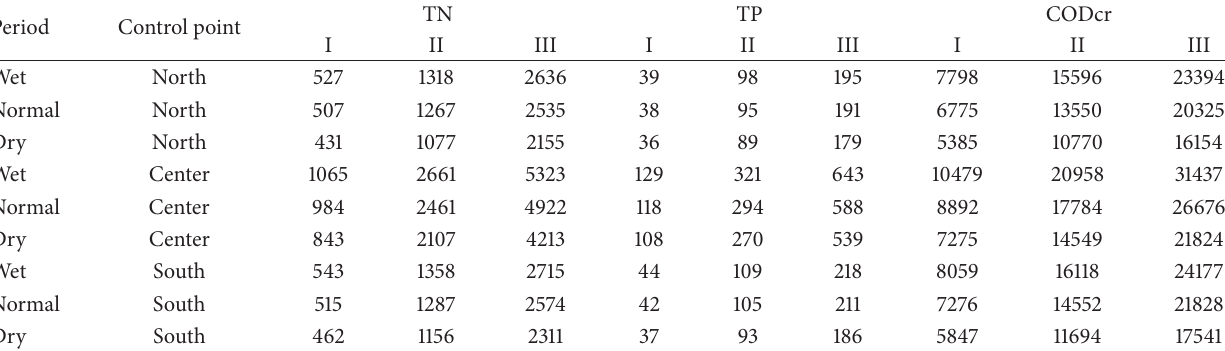
Table 3: The calculations of water environmental capacity in Erhai Lake ( 𝑡/𝑎 ).